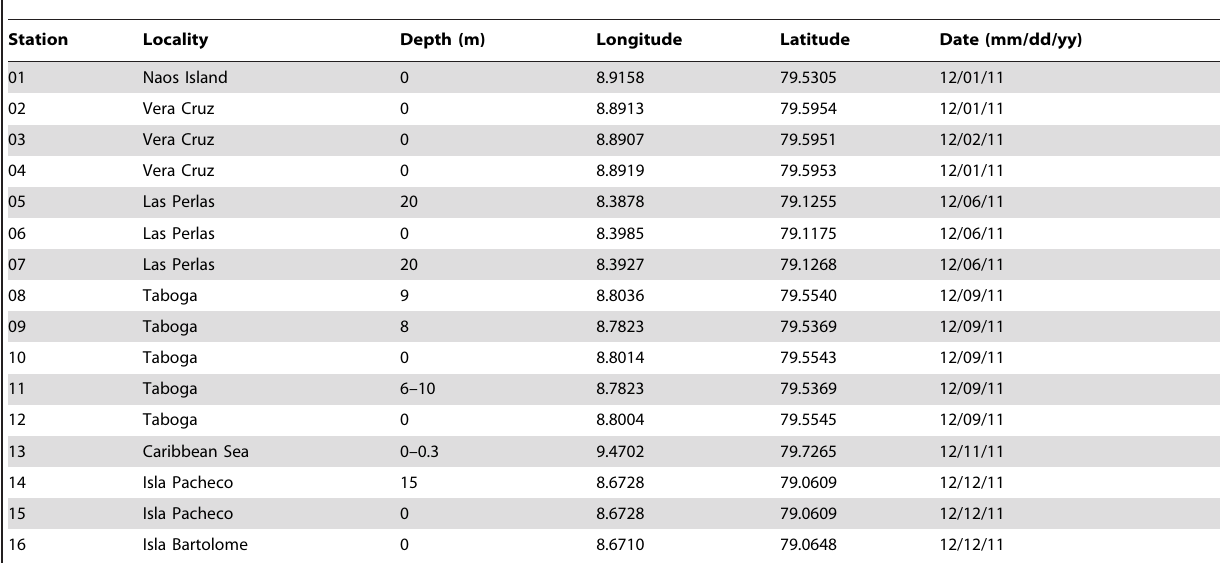
Table 3. Field stations at Naos region, Panama where specimens of Nemertea were